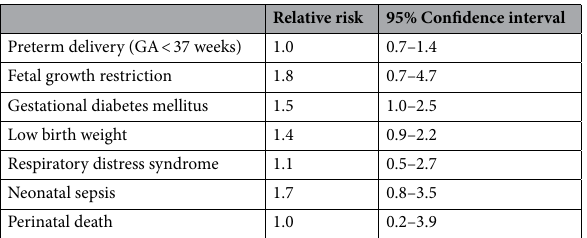
Table 5. Serum HMGB1 levels and uterine artery Doppler for pregnancy complications. HMGB1 High Mobility Group Box-1, GA gestational age.